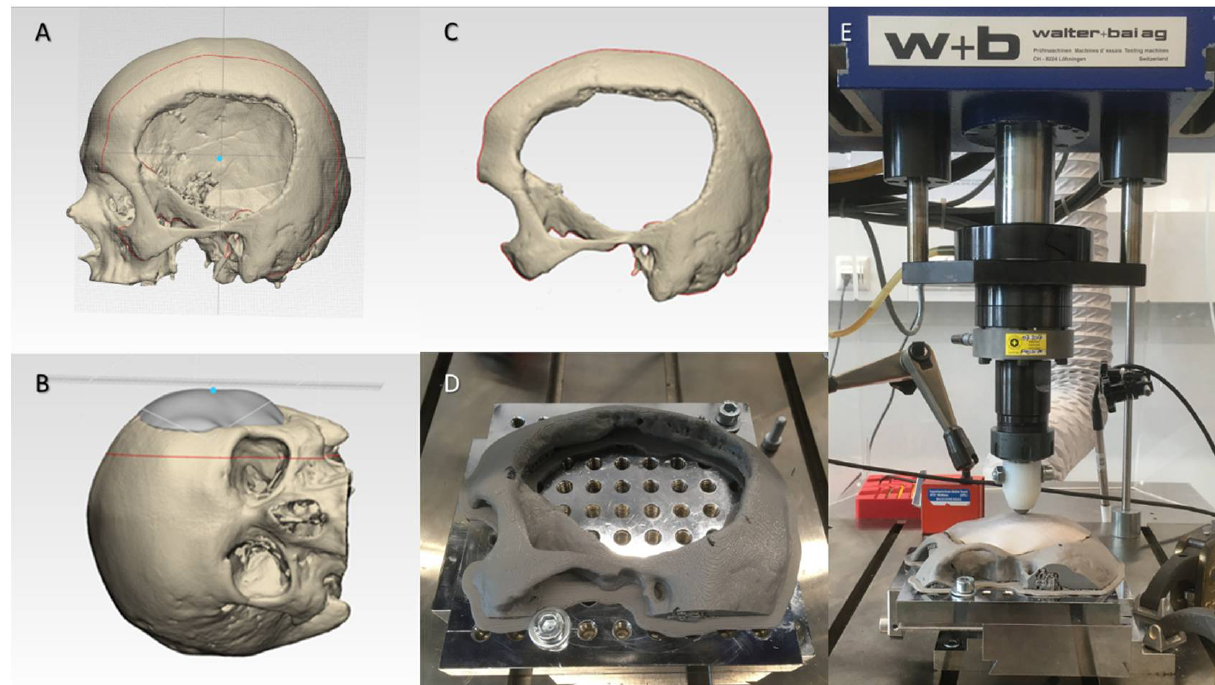
Figure 7. Schematic representation of the steps involved for the biomechanical characterization: ( A ) Computer-aided design (CAD) of a skull model highlighting the centroid mark (blue dot); ( B ) Orientation of the cranial implant along the cartesian axes; ( C ) Computer-aided design (CAD) of the skull template; ( D ) Material extrusion 3D-printed skull template; ( E ) Quasi-static test setup in a servohydraulic system.